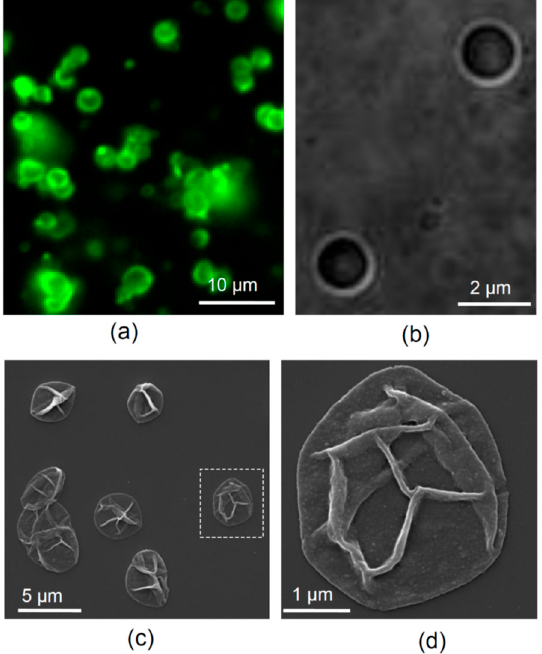
Figure 1. LbL-microcapsules carrying NGF. ( a ) An example of LbL-microcapsules in a suspension (epifluorescence of FITC conjugated to the microcapsule shell). ( b ) A DIC image of microcapsules at higher magnification. ( c ) SEM images of LbL-microcapsules dried and sputtered with gold. ( d ) Dotted rectangle regions in ( c ) shown at higher magnification.